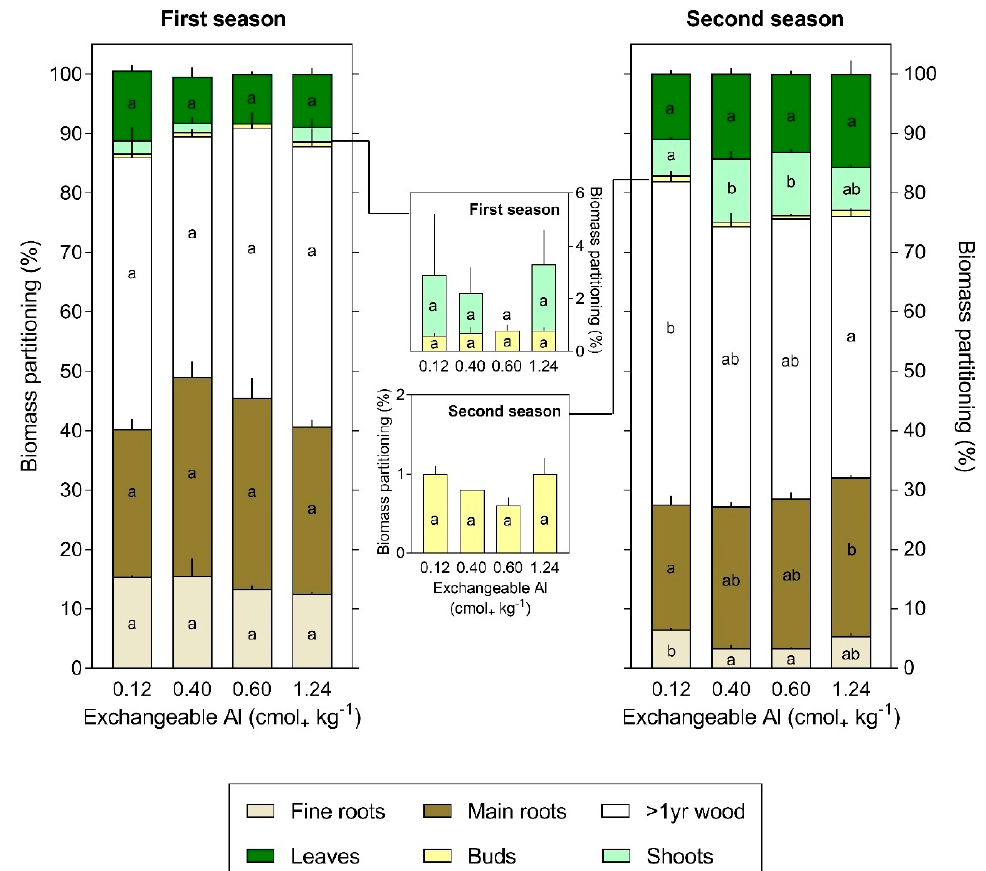
Figure 3. Biomass partitioning in individual organs of sweet cherry trees growing with increasing concentrations of exchangeable Al in a volcanic soil. The vertical bars represent the standard errors ( n = 3). Different small letters in the same organ indicate significant differences between treatments (Tukey’s test; p < 0.05).